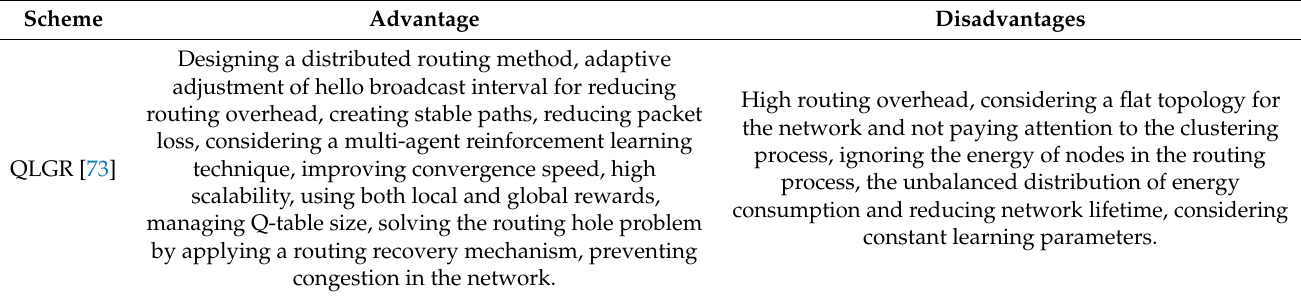
Figure 32. Learning process in QLGR. Table 14. The most important advantages and disadvantages of